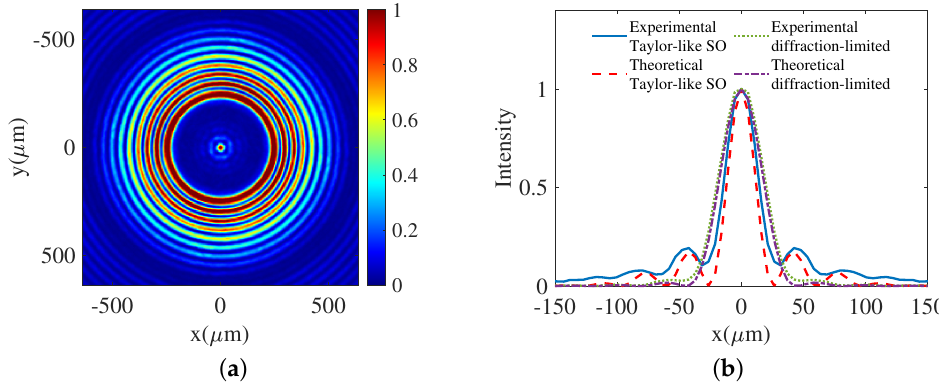
Figure 13. The experimental results of the Taylor-like super-oscillatory point-spread function cor- responding to an one-parameter Taylor-like super-directive array. ( a ) Two-dimensional Taylor-like super-oscillatory point-spread function. ( b ) Experimental (blue line) and theoretical (red dashed line) One-dimensional Taylor-like super-oscillatory point-spread functions. Experimental (green dotted line) and theoretical (purple dot-dashed line) diffraction-limited point-spread functions (red line) at the y = 0 plane. The full widths at half maximum (FWHM) for the experimental and theoretical Taylor-like super-oscillatory point-spread functions, and the experimental and theoretical diffraction- limited point-spread functions are around 29.1 µ m, 24.4 µ m, 40.5 µ m and 37.6 µ m, respectively. The ratio of the experimental Taylor-like FWHM to the experimental diffraction-limited FWHM is